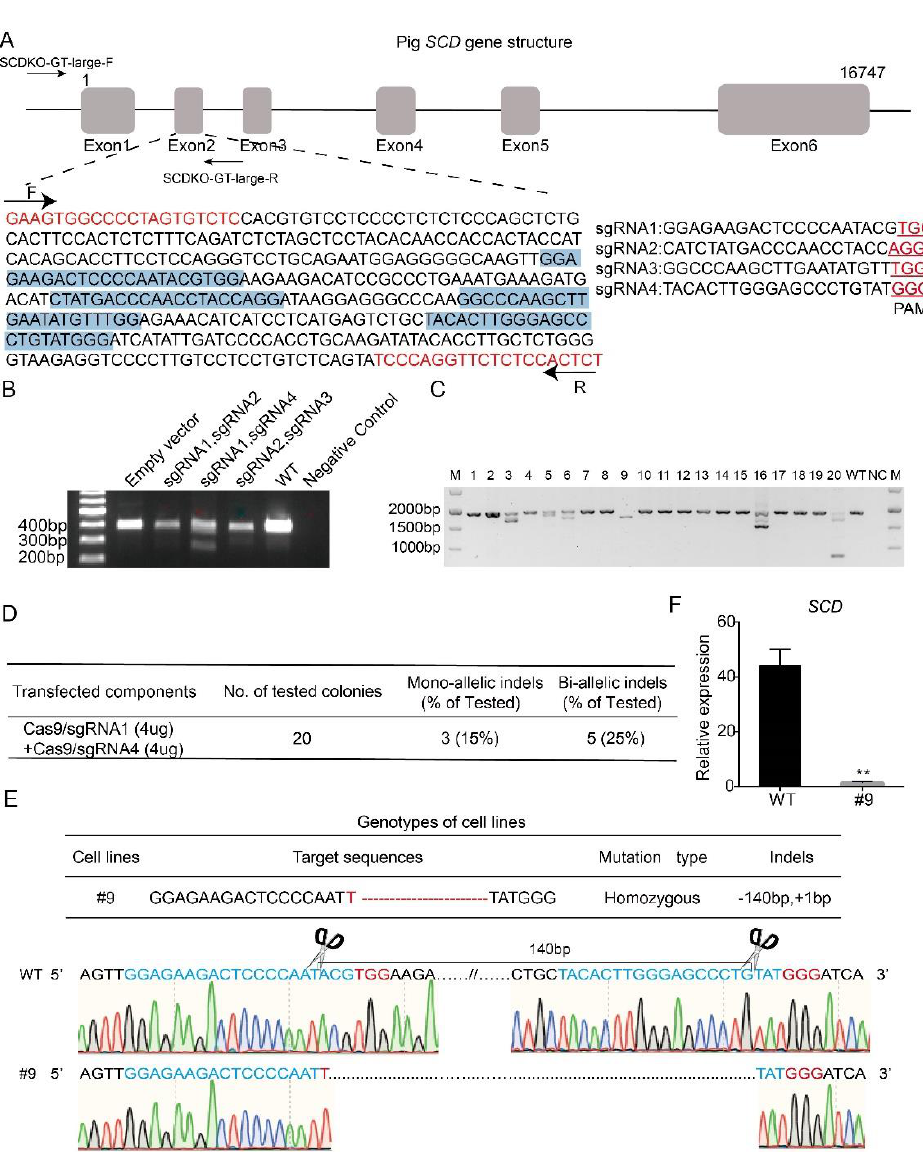
Figure 3. Generation of SCD − / − porcine embryo fibroblasts. ( A ) Gene structure of the porcine SCD gene and the location of the four sgRNAs that target exon 2 (highlighted in blue). Primers designed to estimate the target e ffi ciency are also indicated, and the predicted PCR size is 403 bp (highlighted in red). ( B ) Di ff erent pairs of vectors containing sgRNA, including sgRNA1-sgRNA2, sgRNA1-sgRNA4 and sgRNA2-sgRNA3, were selected for co-transfecting cells, because of a potential frame shift e ff ect. A template with H 2 O was used as a negative control, and the DNA in the transfected empty vector was used as a positive control. Notably, the short band was observed in cells co-transfected with sgRNA1 and sgRNA4, and this pair of sgRNAs was then used for the remaining studies. ( C ) Plasmids containing sgRNA1 and sgRNA4 were co-transfected in porcine embryonic fibroblasts (PEFs), and single cells were sorted by flow cytometry and seeded into 96-well plates. A total of 20 single-cell colonies were selected for PCR and sequencing analysis. ( D ) Estimation of targeting e ffi ciency. Notably, 5 biallelic mutant clones were identified, and the targeting e ffi ciency was 25%. ( E ) Targeted sequence information of #9 colony. ( F ) Knockout e ffi ciency of SCD in the #9 colony was examined by real-time PCR; ** p <